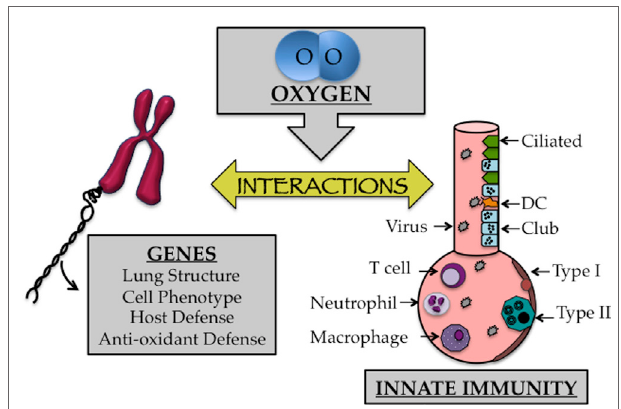
FiGURe 2 | The early life oxygen environment affects changes in genetic as well as innate immune mechanisms . Cartoon depicting the affect early life oxygen environment imparts on genes that specify lung structure and function with cells involved in innate